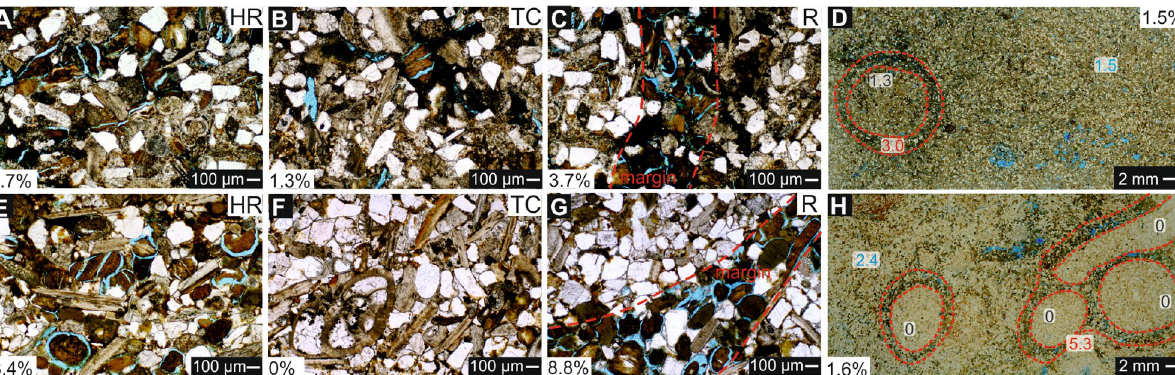
Figure 2. Close-ups from El Adergha ( A – D ) and Kirmta ( E – H ). ( A , E ) Close-ups from host rock (HR). ( B , F ) Tube cores (TC). ( C , G ) Rims (R). ( D , H ) Thin sections. Percentage values show the porosity in every case; in ( C ) and ( G ) this is just referred to the rim. In thin sections ( D ) and ( H ), values measured in tube cores (black), rims (red), and host sediment